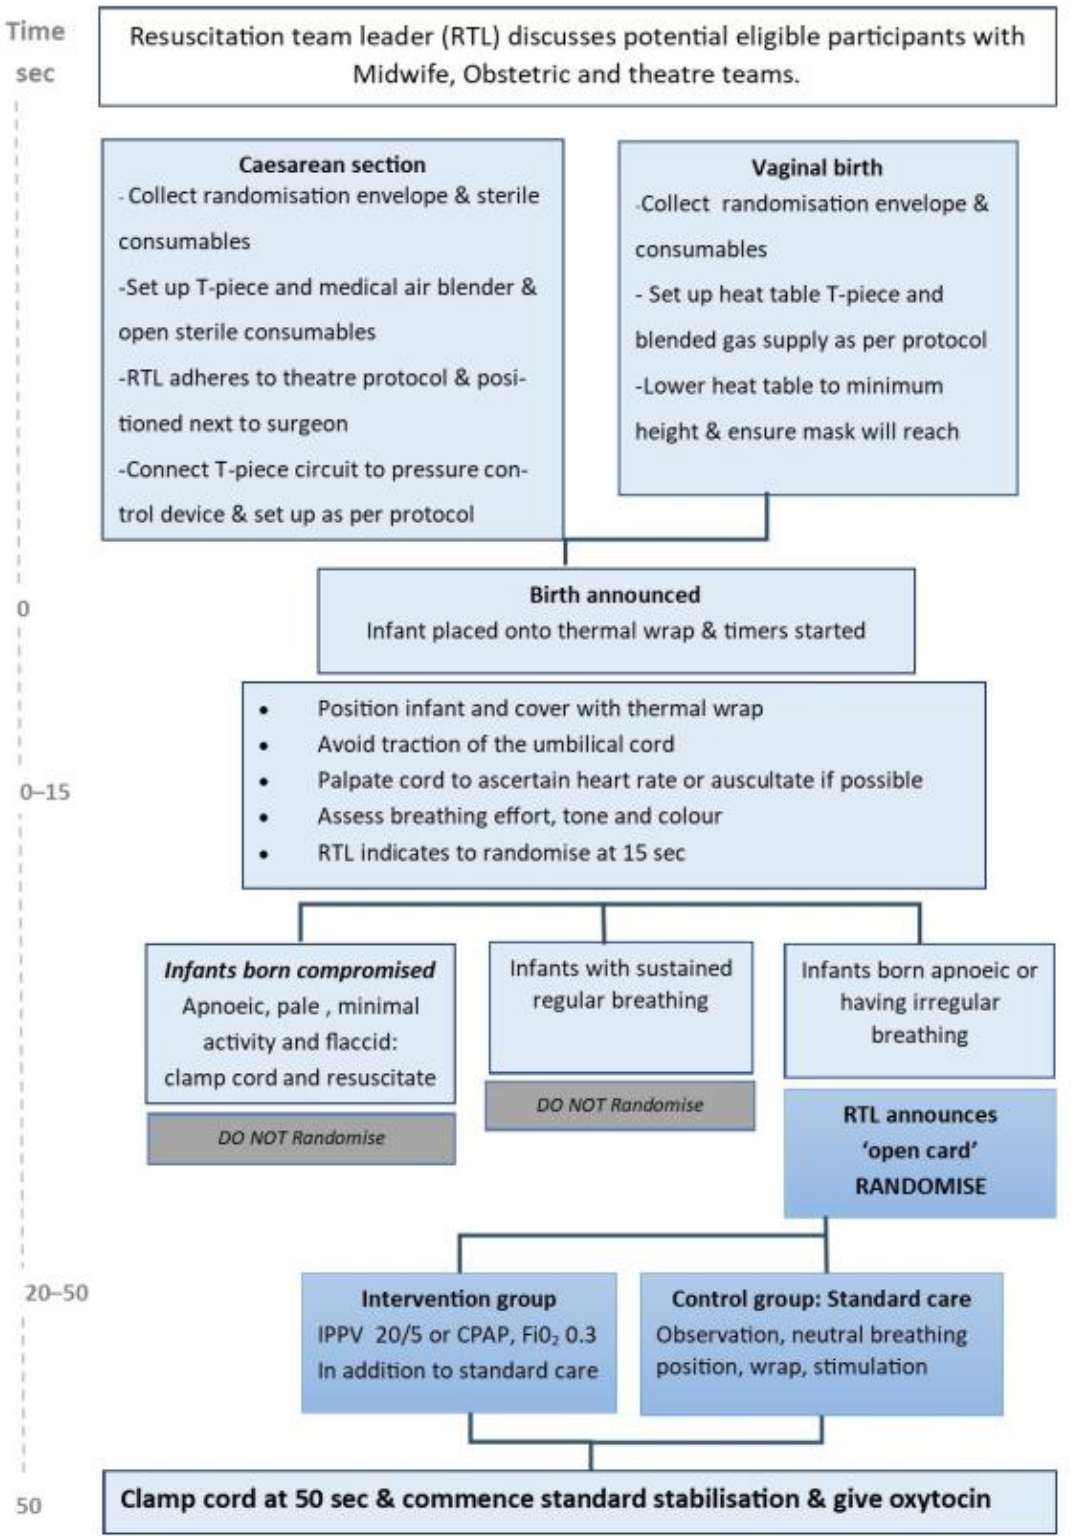
Figure 1. ABC Study flow diagram.